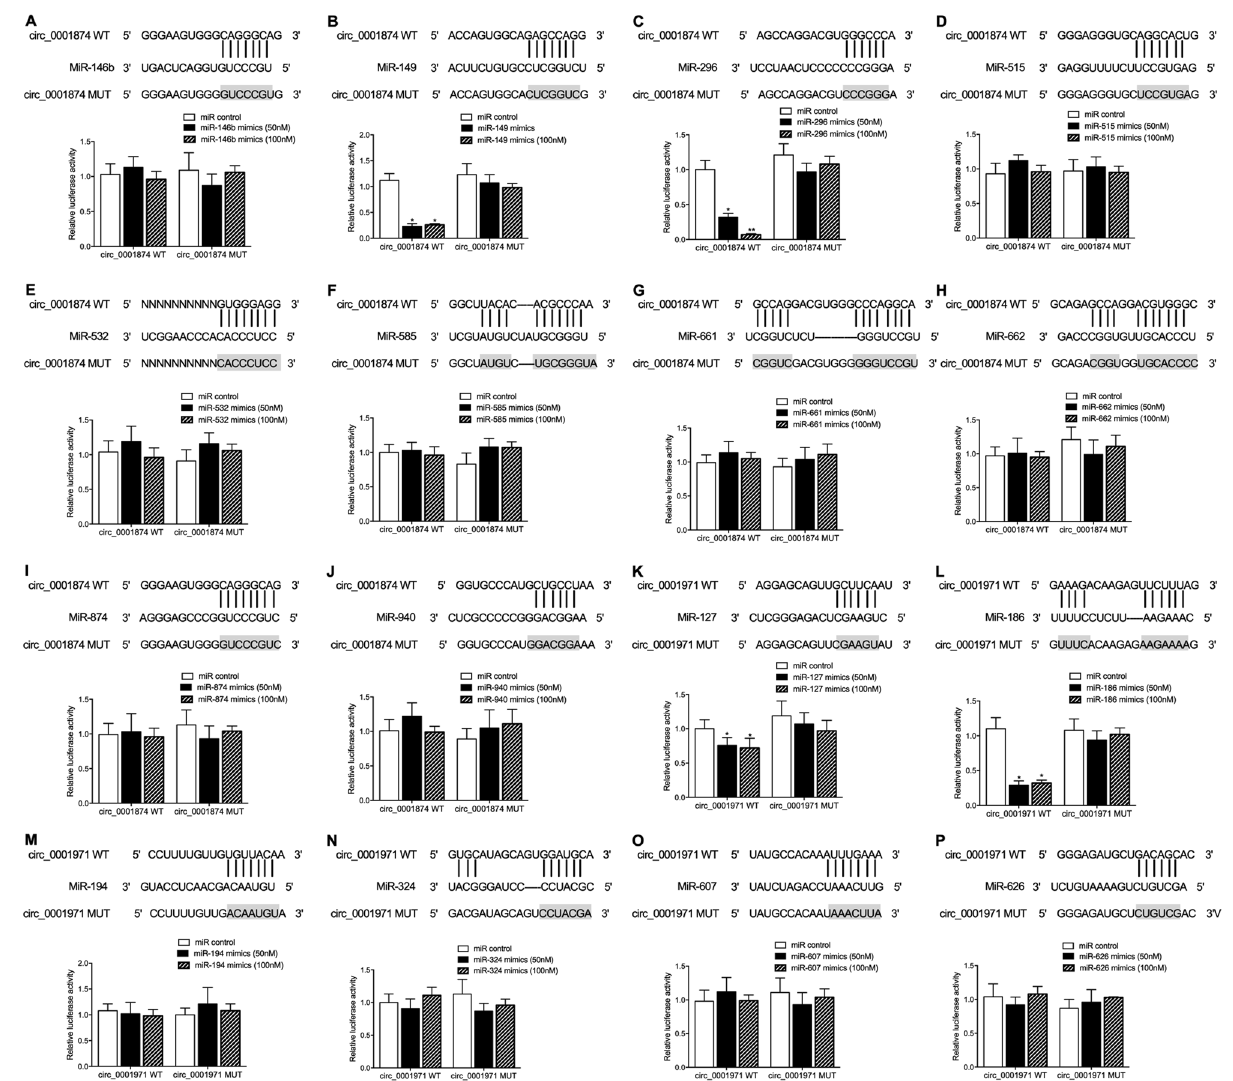
Figure 2. Computational analysis and luciferase assays validated the molecular relationships between miR-296-5p and circ_0001874, and between miR-186 and circ_0001971. ( A ) Computational analysis and luciferase assay of circ_0001847 and miR-146b-3p indicated no molecular relationship between circ_0001847 and miR-146b-3p; ( B ) Computational analysis and luciferase assay of circ_0001847 and miR-149 indicated that the luciferase activity of circ_0001847 was significantly reduced by miR-149 mimics at both high and low dosages (*P value < 0.05 vs. miR control); ( C ) Computational analysis and luciferase assay of circ_0001847 and miR-296 indicated that the luciferase activity of circ_0001847 was significantly reduced by miR-296 mimics in a dose-dependent manner (*P value < 0.05 vs. miR control); ( D ) Computational analysis and luciferase assay of circ_0001847 and miR-515-3p indicated no molecular relationship between circ_0001847 and miR-515-3p; ( E ) Computational analysis and luciferase assay of circ_0001847 and miR-532-3p indicated no molecular relationship between circ_0001847 and miR-532-3p; ( F ) Computational analysis and luciferase assay of circ_0001847 and miR-585 indicated no molecular relationship between circ_0001847 and miR-585; ( G ) Computational analysis and luciferase assay of circ_0001847 and miR-661 indicated no molecular relationship between circ_0001847 and miR-661; ( H ) Computational analysis and luciferase assay of circ_0001847 and miR-662 indicated no molecular relationship between circ_0001847 and miR-662; ( I ) Computational analysis and luciferase assay of circ_0001847 and miR-874 indicated no molecular relationship between circ_0001847 and miR-874; ( J ) Computational analysis and luciferase assay of circ_0001847 and miR-940 indicated no molecular relationship between circ_0001847 and miR-940; ( K ) Computational analysis and luciferase assay of circ_0001971 and miR-127 indicated that the luciferase activity of circ_0001971 was significantly reduced by miR- 127 mimics at both high and low dosages (*P value < 0.05 vs. miR control); ( L ) Computational analysis and luciferase assay of circ_0001971 and miR-186 indicated that the luciferase activity of circ_0001971 was significantly reduced by miR-186 mimics at both high and low dosages (*P value < 0.05 vs. miR control); ( M ) Computational analysis and luciferase assay of circ_0001971 and miR-194 indicated no molecular relationship between circ_0001971 and